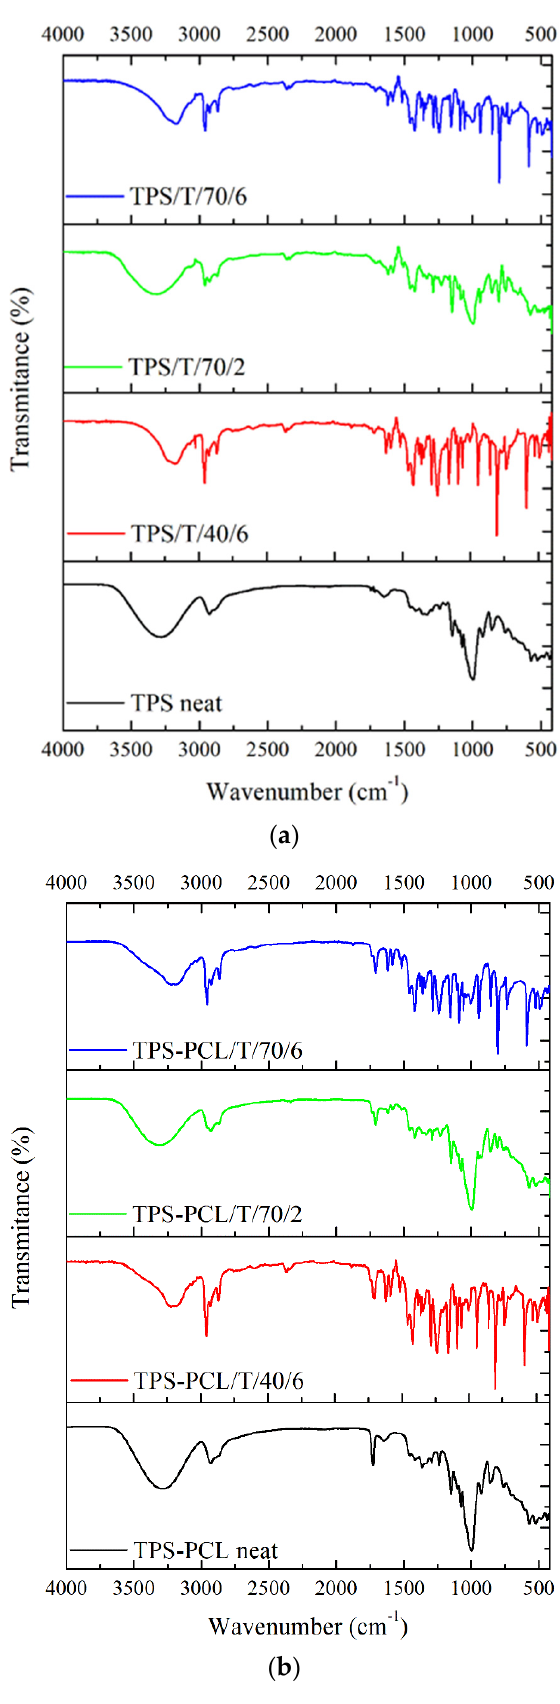
Figure 3. FTIR spectra of neat and thymol-impregnated: ( a ) TPS samples; ( b ) TPS–PCL samples. All TPS samples displayed a wide band in the range of 3600–3000 cm − 1 , which corre- sponds to the stretching vibration of the O–H groups of starch [31,32] (groups of amylose,